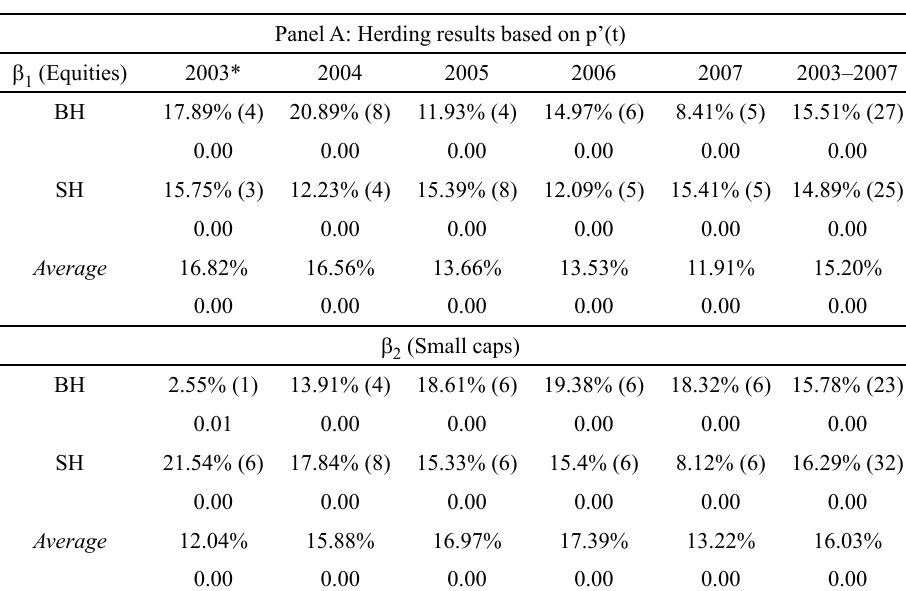
Table 5. Herding results based on p’ ( t ) Panel A: Herding results based on